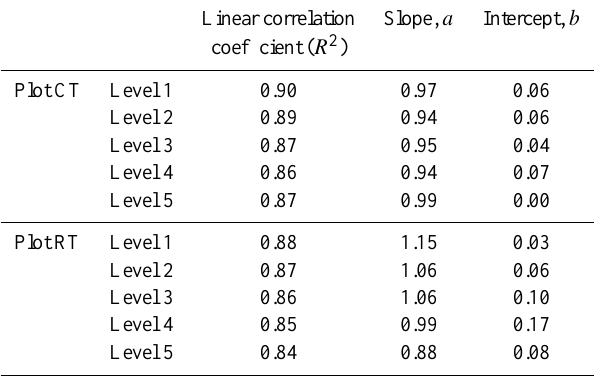
Table 3. Parameters of the linear regression between the mod- elling and the experimental data of the variance according to the anemometer levels Linear correlation Slope,